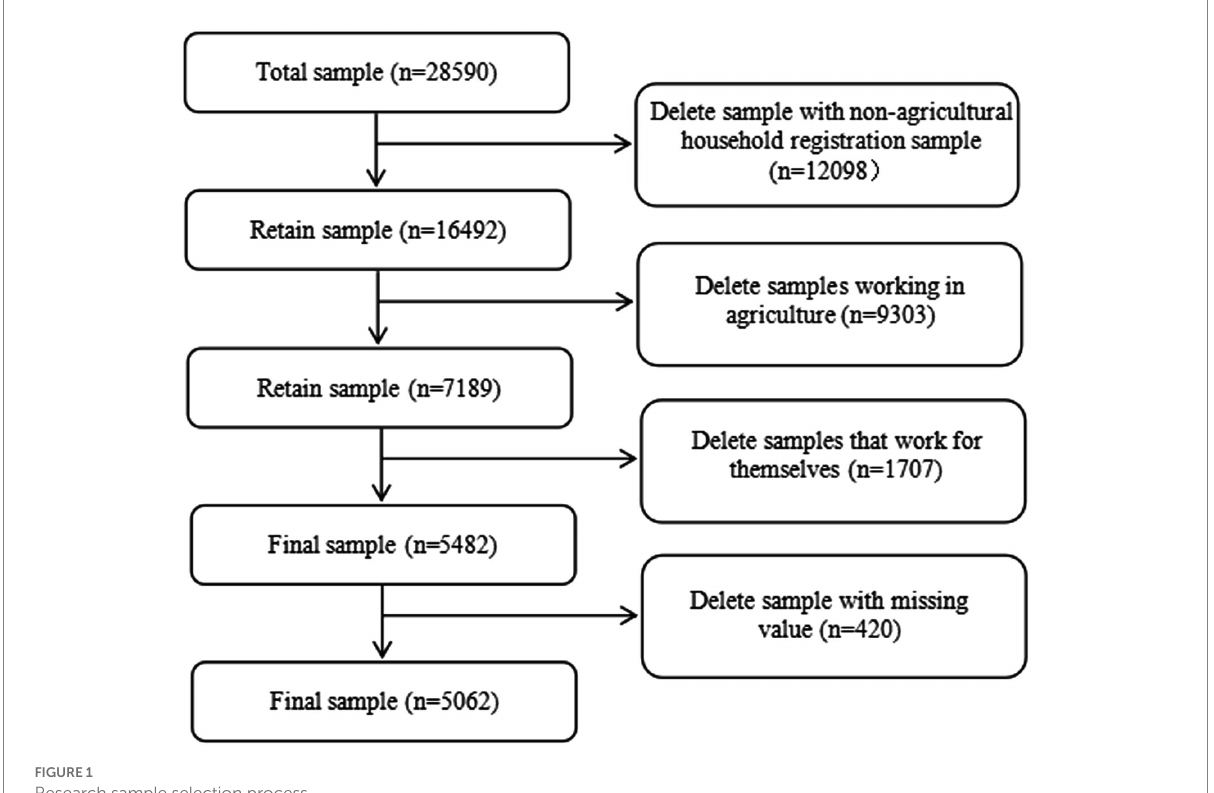
FIGURE 1 Research sample selection